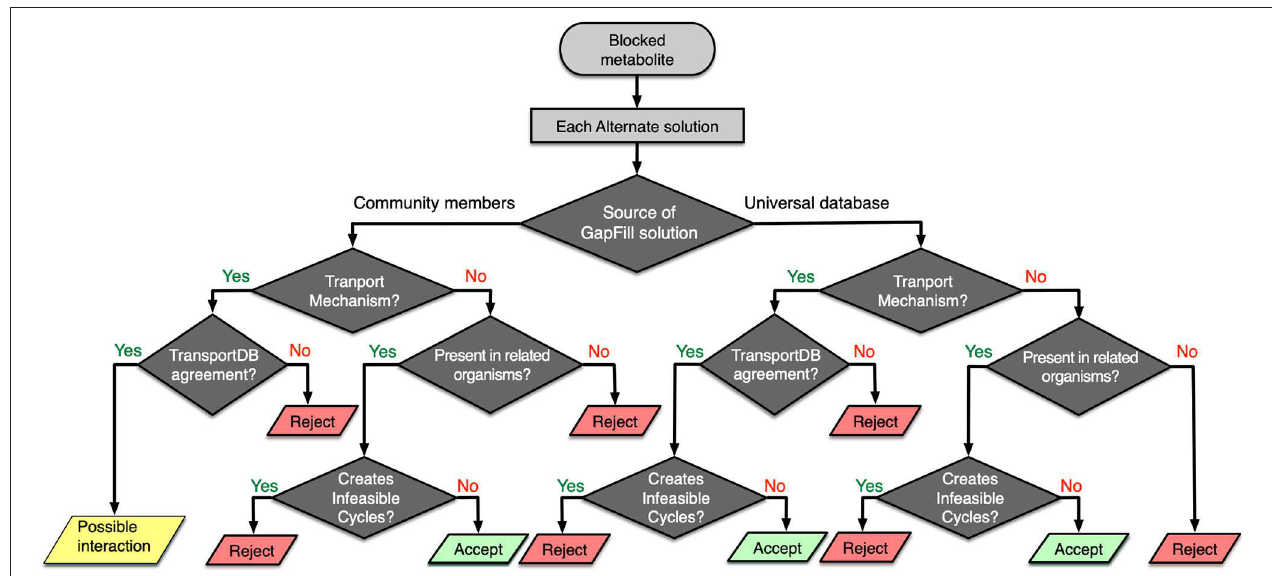
FIGURE 6 | Workflow for identifying possible interspecies interactions and filtering GapFill